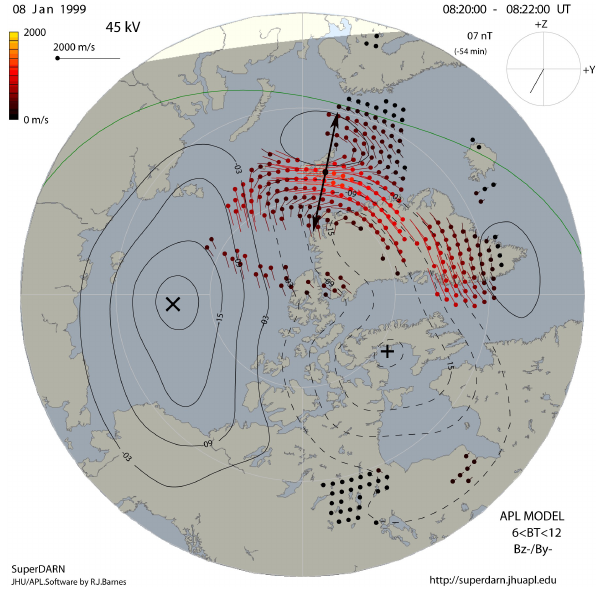
Fig. 17. SuperDARN convection data for 08:20–08:22UT. Same format as in Fig. 8.